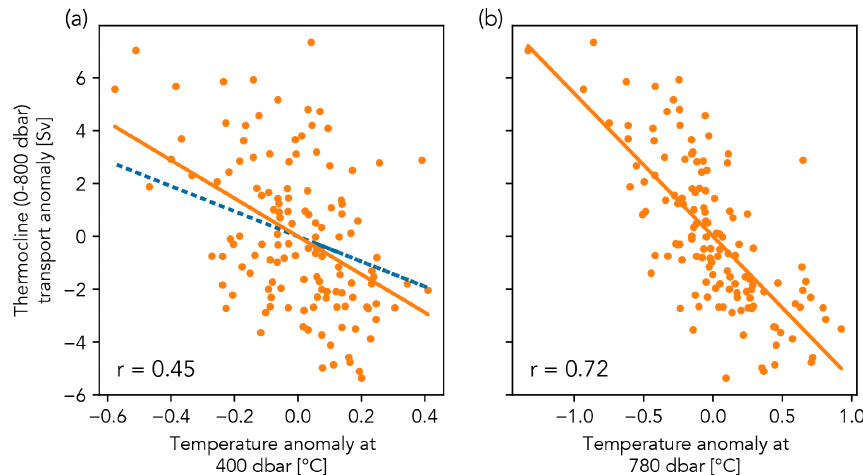
Figure 2. Linear regression of the monthly mean RAPID thermocline (0–800m) transport anomaly on the monthly mean conservative temperature anomaly at (a) 400dbar and (b) 780dbar from the RAPID western boundary profiles. The orange line is the regression equation for these data; the blue dashed line in (a) shows the equivalent regression from Longworth et al. (2011) for the same data. The Pearson’s correlation coefficient ( r ) is shown for each model